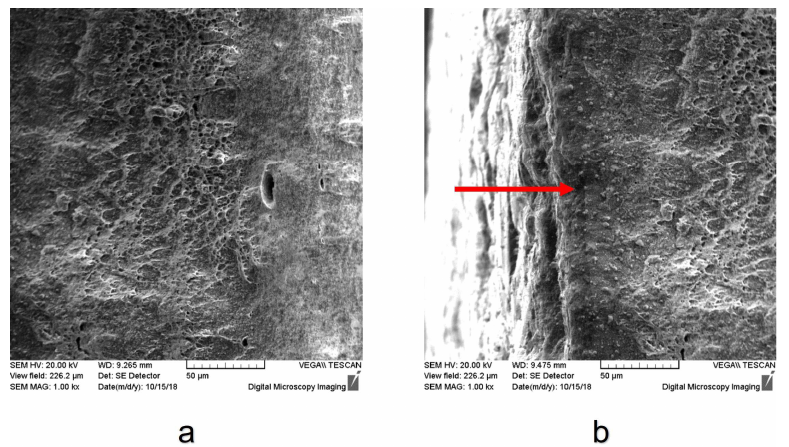
Figure 17. SEM micrographs of the fracture surface of 316L steel at 400 °C at 1000× magnification, showing different areas in ( a , b ).